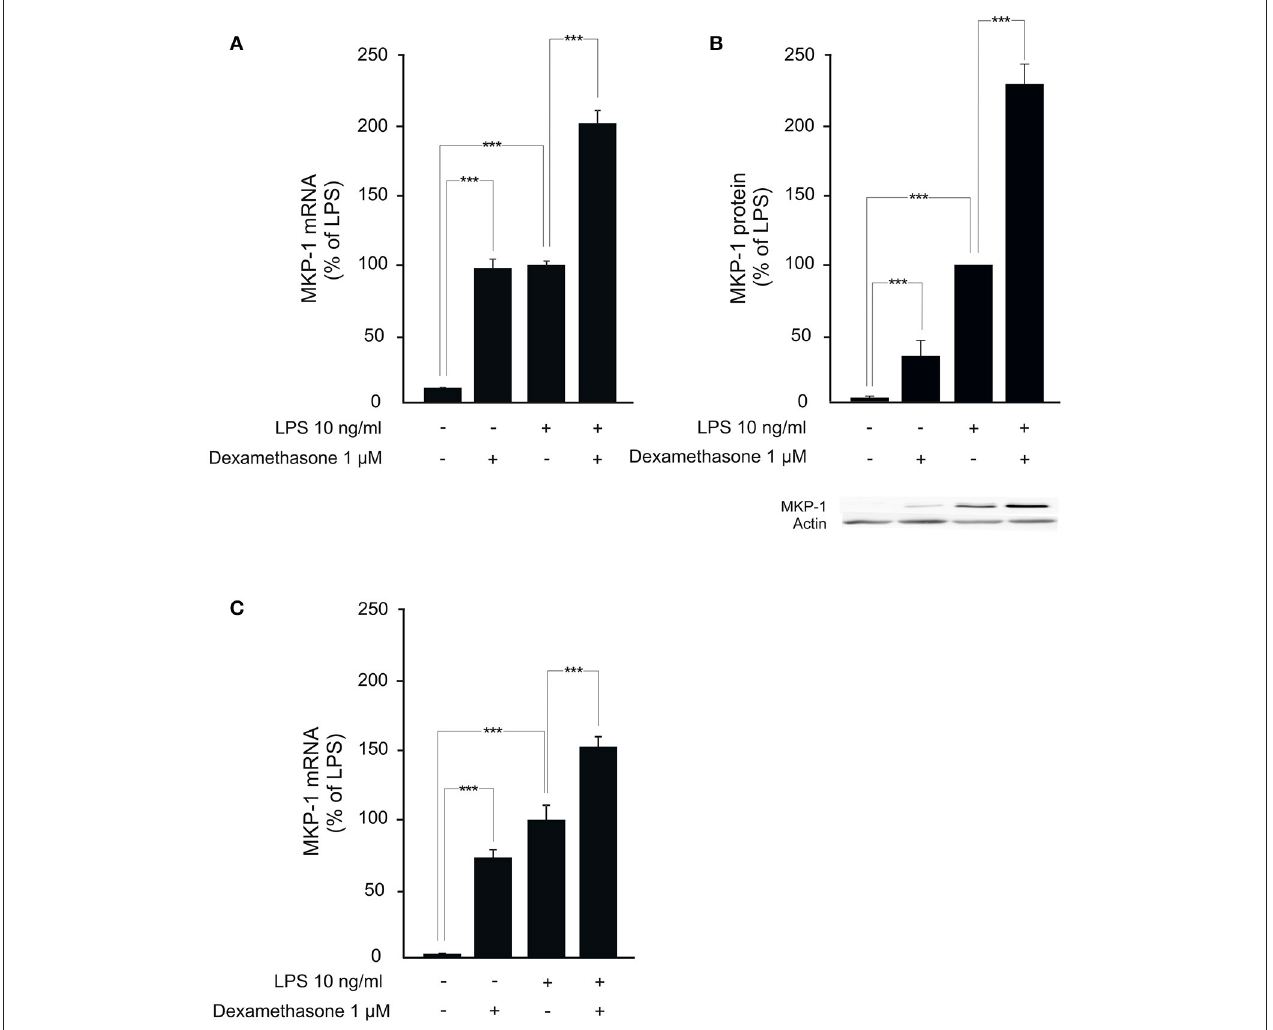
FIGURE 3 | Dexamethasone enhances MKP-1 expression in macrophages. (A) Effect of dexamethasone on MKP-1 mRNA expression in J774 murine macrophages. Cells were stimulated with LPS in the presence or absence of dexamethasone for 1 h. MKP-1 mRNA levels were measured by quantitative RT-PCR and normalized against GAPDH mRNA levels. Results are given in arbitrary units, MKP-1 mRNA levels in LPS-stimulated cells were set as 100% and the other values were related to that. Results are expressed as mean + SEM, n = 11–12. One-way ANOVA with Bonferroni’s post-test was performed and statistical significance is indicated as *** P < 0.001. (B) Effect of dexamethasone on MKP-1 protein expression in J774 murine macrophages. Cells were stimulated with LPS in the presence or absence of dexamethasone for 1 h. MKP-1 protein levels were measured by Western blot analysis and actin was used as a loading control. Results are expressed in arbitrary units, MKP-1 protein levels in LPS-stimulated cells were set as 100% and the other values were related to that. Results are expressed as mean + SEM. n = 9. One-way ANOVA with Bonferroni’s post-test was performed and statistical significance is indicated as *** P < 0.001. Shown is a representative gel of nine with